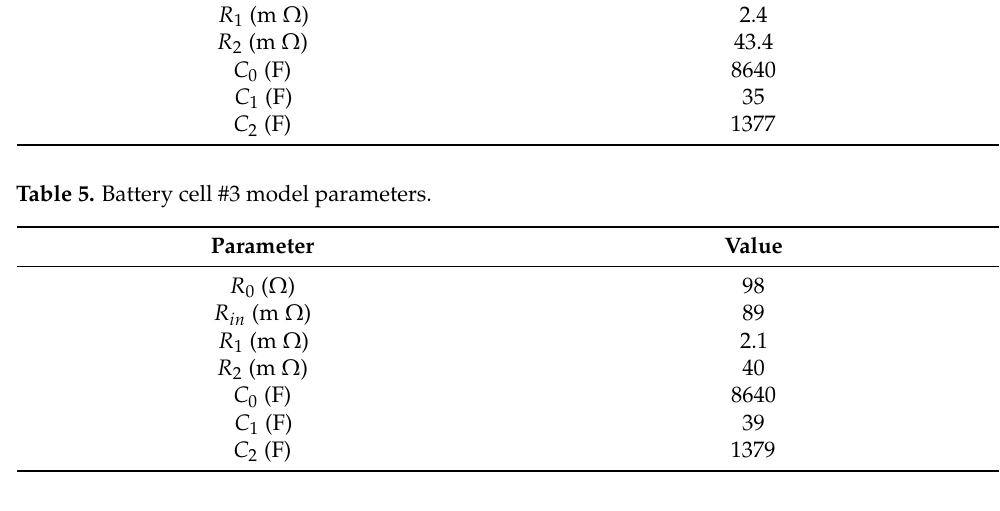
Table 4. Battery cell #2 model parameters. Table 5. Battery cell #3 model parameters.